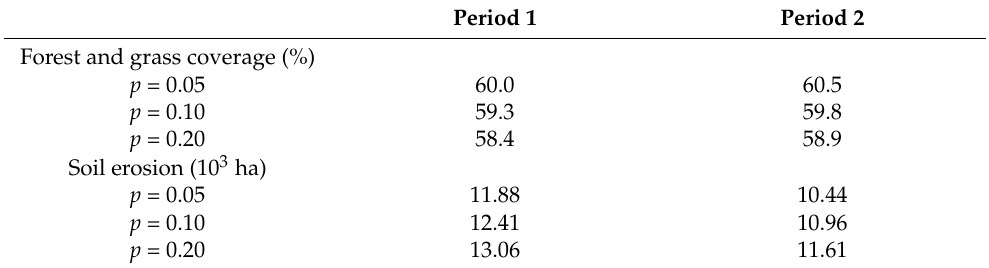
Table 3. Results of Monte Carlo simulation.